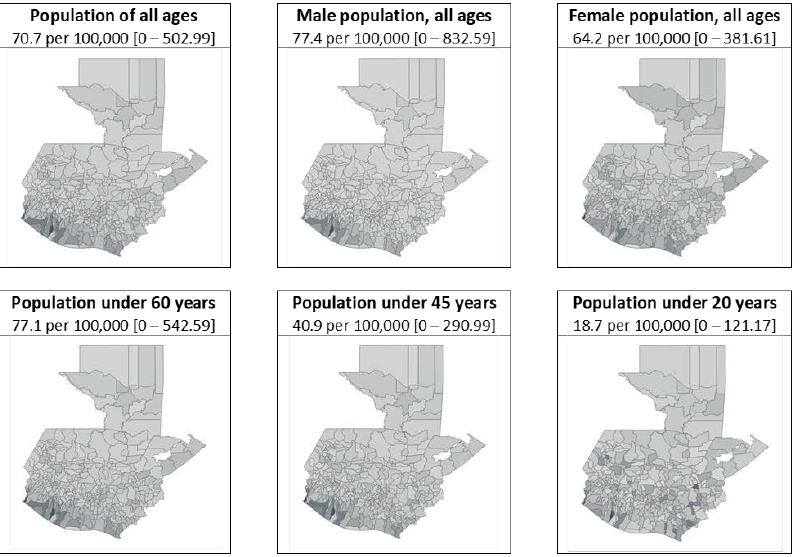
Figure 2. Municipal crude mortality rates for chronic kidney disease, Guatemala 2009–2019 ( N = 340 municipalities), by gender and age group. Mean and range. Age groups are not mutually exclusive. Darker shades represent higher rates.